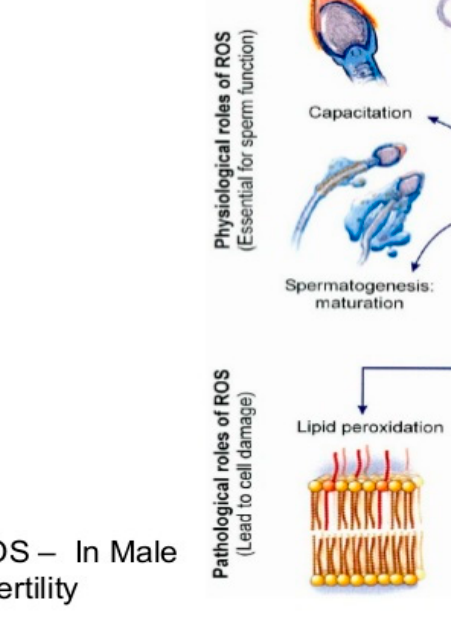
Figure 13. Contradictory role of ROS in spermatogenesis. Source: [142].